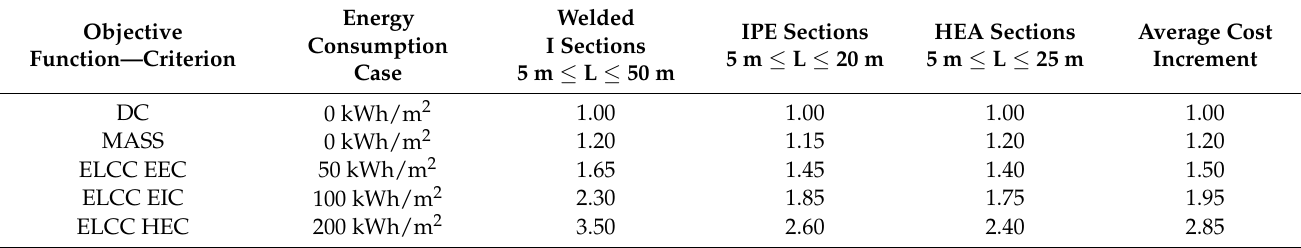
Table 3. Cost increment factors related to the calculated costs of different criteria and different steel